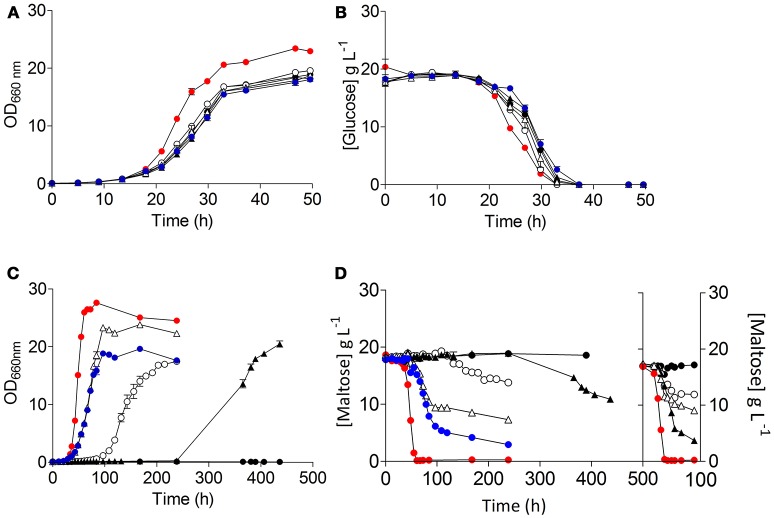
Characterization of the S. cerevisiae strains () IMZ616 (Marques et al., 2018), () IMX1253 (ScTEF1pr-SeMALT1-ScCYC1ter), () IMX1254 (ScTEF1pr-SeMALT2-ScCYC1ter), () IMX1255 (ScTEF1pr-SeMALT3-ScCYC1ter), () IMX1365 (ScTEF1pr-ScMAL11-SeCYC1ter), and () S. eubayanus CBS 12357T. The strains were grown in SMUG and SMUM at 20°C. Growth on glucose (A) and on maltose (C) was monitored based on optical density measurement at 660 nm (OD660nm). Concentrations of glucose (B) and maltose (D) in culture supernatants were measured by HPLC. (D) Shows the data of two consecutive batches. Data are presented as average and standard deviation of three biological replicates.